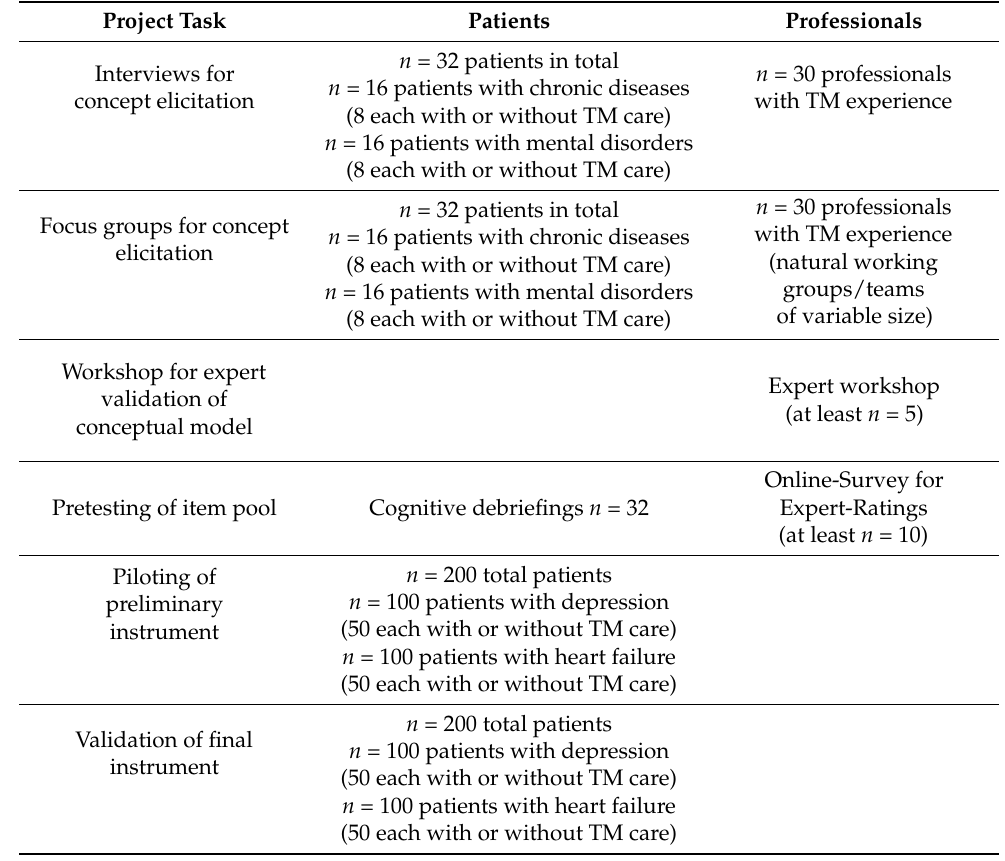
Table 1. Sample sizes per study